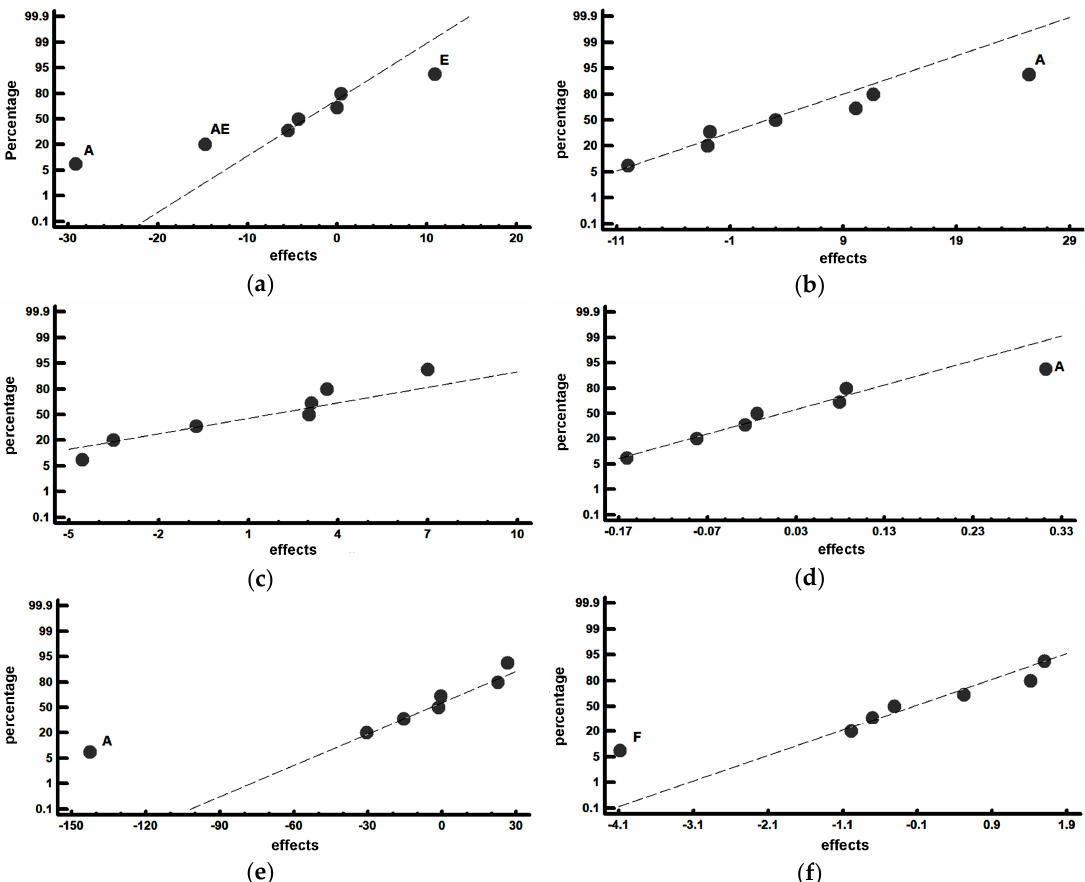
Figure 4. Representation of the effects on a normal probability plot. Those factors with a significant effect on the analysed responses are highlighted. ( a ) Percentage by weight of martensite; ( b ) Percentage by weight of austenite; ( c ) Percentage by weight of type K2 carbides; ( d ) Volume of the austenite crystal cell (Å 3 ); ( e ) Vickers hardness; and ( f ) Weight loss in the erosive wear test (mg).